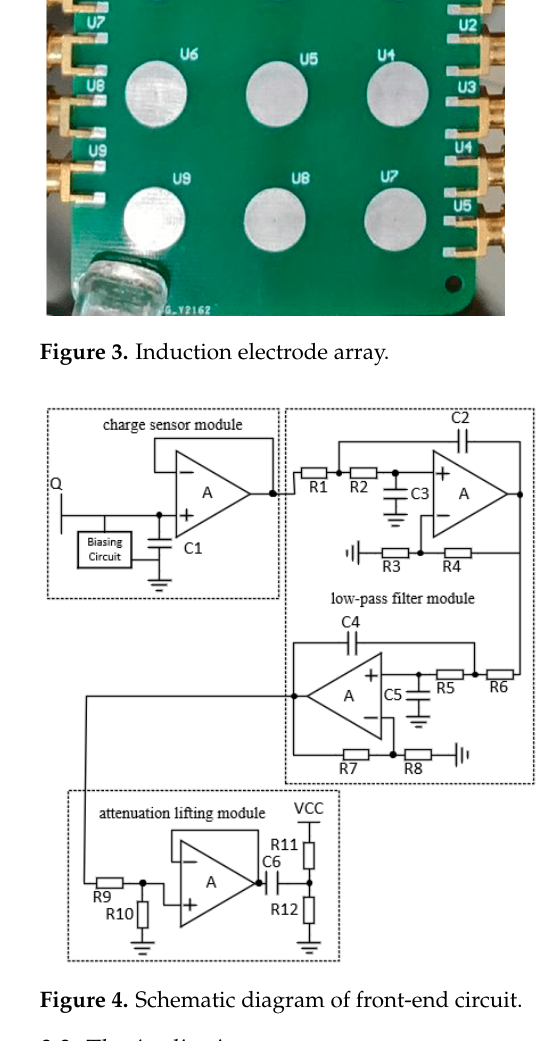
Figure 5. Main window of the application.